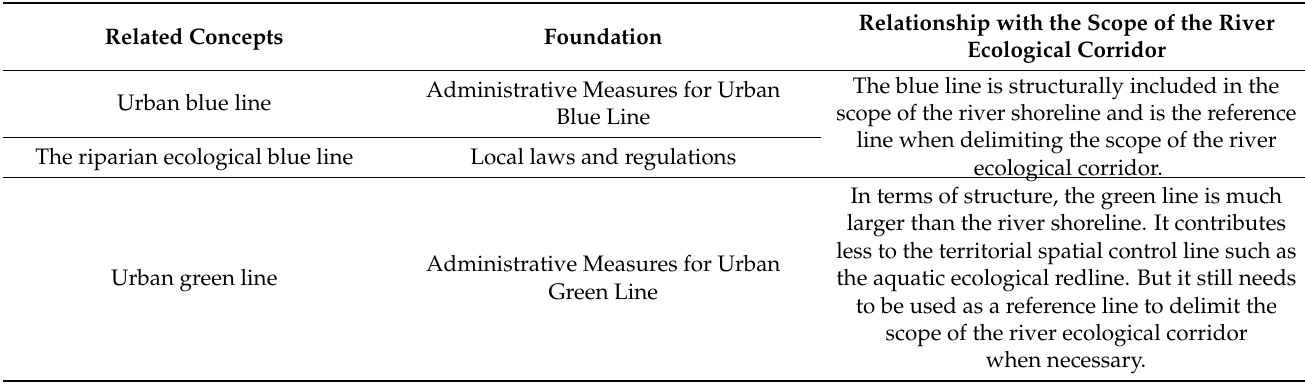
Table 3. Relationship between other scope lines and the river ecological corridor